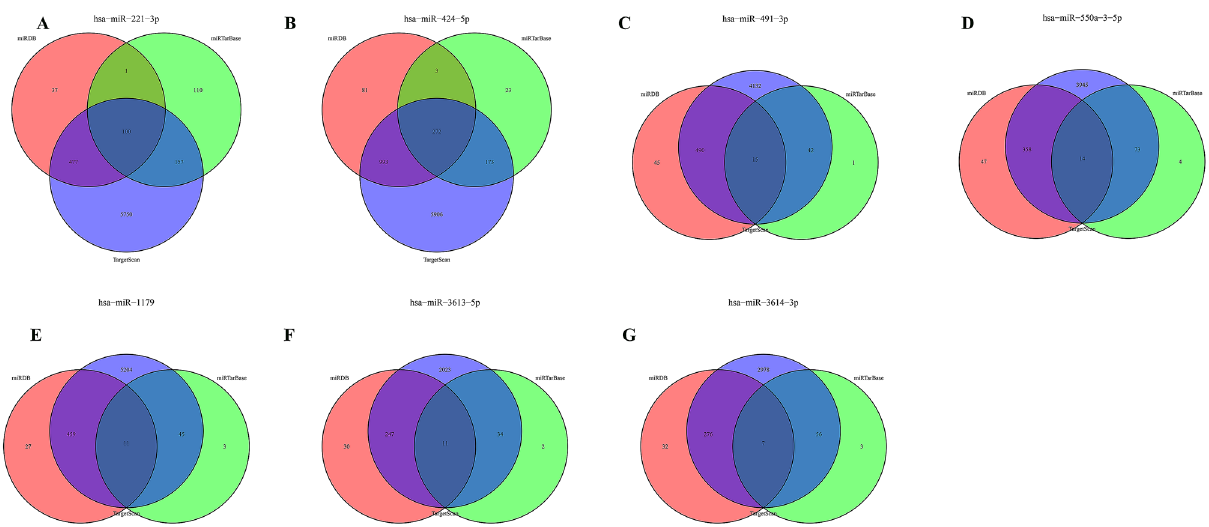
Figure 8. miRNA target Venn. ( A ) Venn diagram of target genes for hsa-miR-221-3p; ( B ) Venn diagram of target genes for hsa-miR-424-5p; ( C ) Venn diagram of target genes for hsa-miR-491-3p; ( D ) Venn diagram of target genes for hsa-miR-550a-3-5p; ( E ) Venn diagram of target genes for hsa-miR-1179; ( F ) Venn diagram of target genes for hsa-miR-3613-5p; ( G ) Venn diagram of target genes for